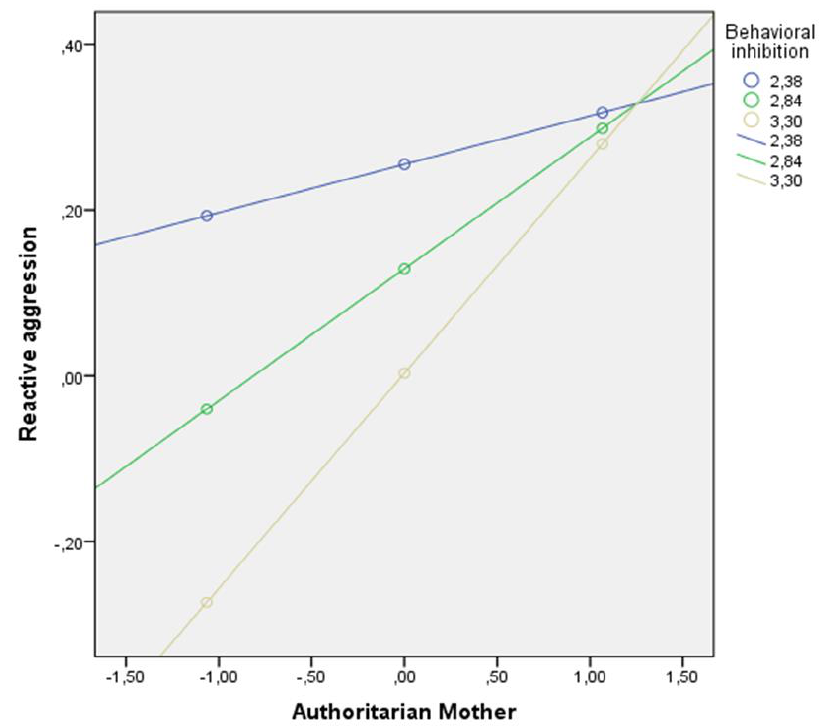
Figure 1. Interaction between surgency and the father ’ s authoritarian parenting style in relation to reactive aggression in boys.